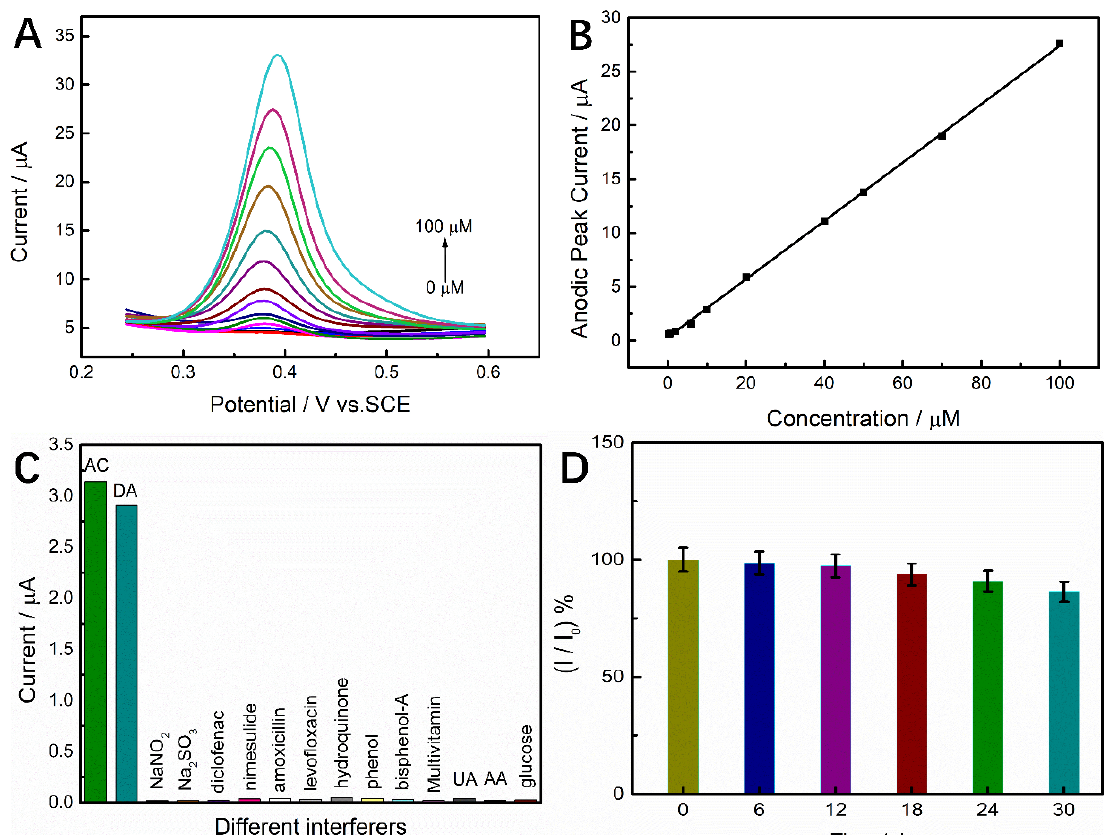
Figure 6. ( A ) DPV curves of Fe − NC − 800/GCE with di ff erent concentrations of AC (0–100 µM) in 0.1 mol/L CPB (pH = 6.8), di ff erent color lines in the graph represent the DPV curves with di ff erent concentrations of AC added. ( B ) The corresponding calibration curve of AC concentration and current. ( C ) Response currents of Fe − NC − 800/GCE in 0.1 mol/L CPB (pH = 6.8) to 10µM AC and ten times the concentration of interferents (uric acid (UA), glucose, dopamine (DA), ascorbic acid (AA), sodium nitrite, sodium sul fi te, diclofenac, nimesulide, amoxicillin, levo fl oxacin, hydroquinone, bisphenol A, phenol, multivitamin tablets), di ff erent color columns represent the response current of Fe − NC − 800/GCE to AC and di ff erent interferents ( D ) Long − term stability experiment of AC sensor based on Fe − NC − 800 (0–30 d), the di ff erent color columns represent the response current of Fe − NC − 800/GCE to the same con-centration of AC after the current number of days of placement.